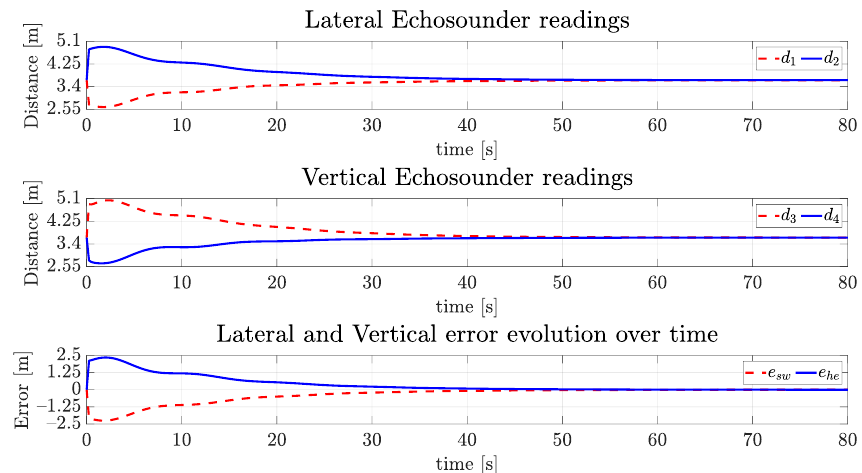
Figure 14. Readings of echosounders of the simulated vehicle and the vertical and horizontal errors over time for the straight path.